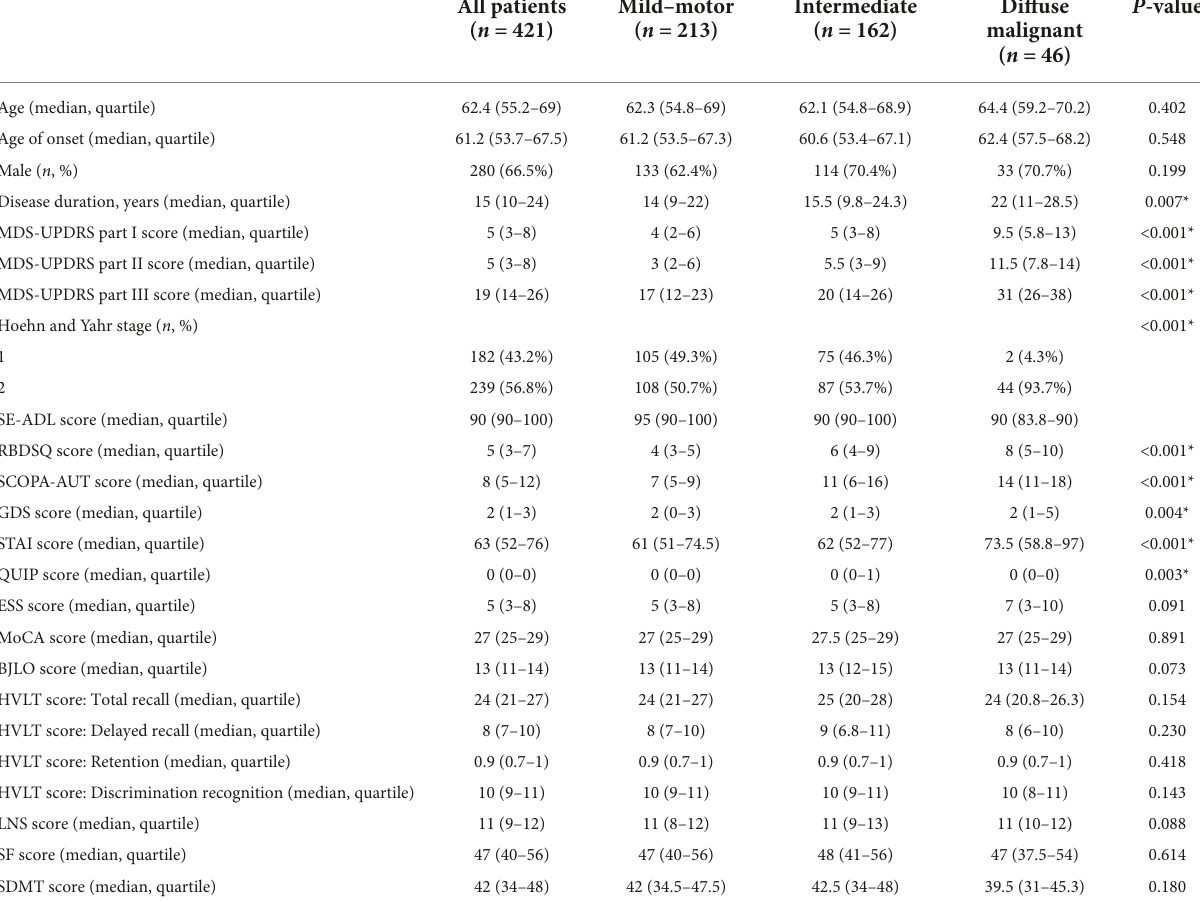
TABLE 1 Baseline characteristics of all